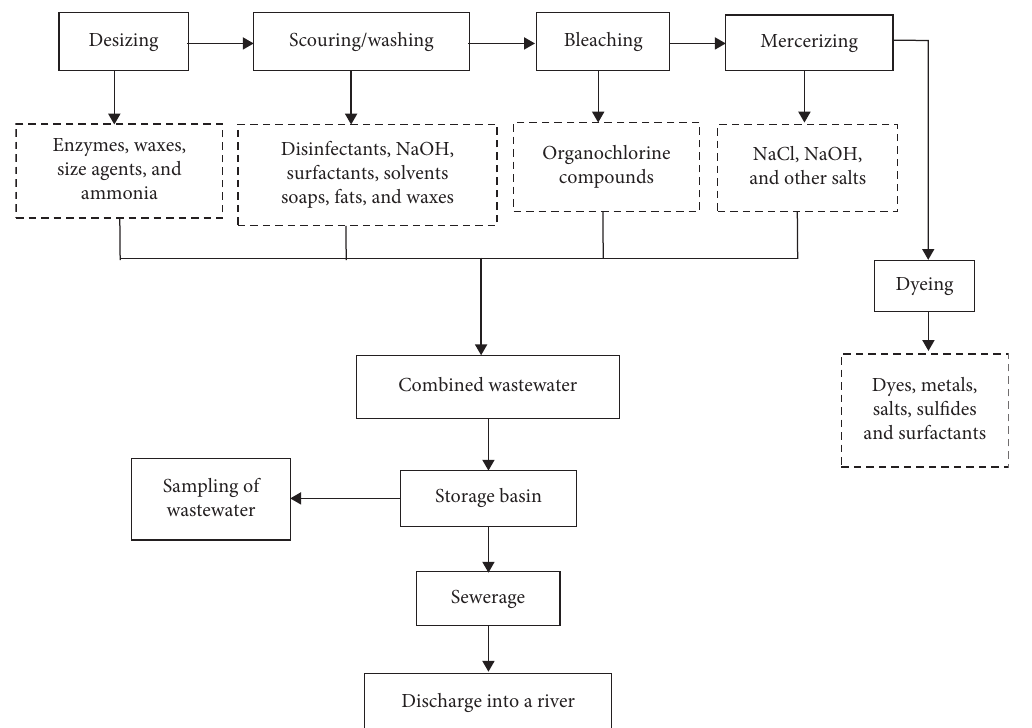
Figure 1: Scheme of production processes in sampling site and the main pollutants from each